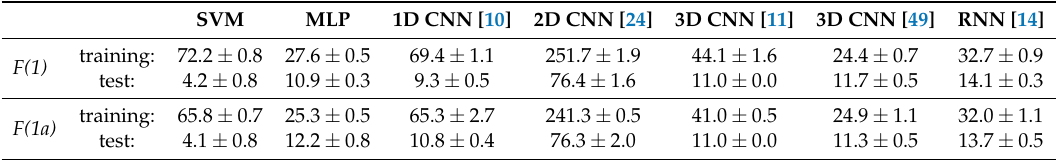
Table A1. The mean computation time with standard deviation (in seconds) of the full pipeline for each method. Consecutive rows present run times for all images, both for the training and the test of the given